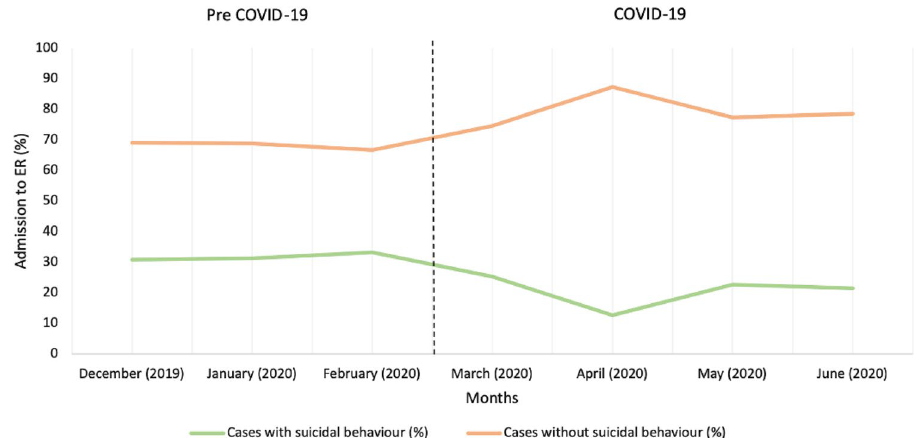
Fig. 1 Trend (%) of those with suicidal behavior and those without (N = 799). ER emer- gency